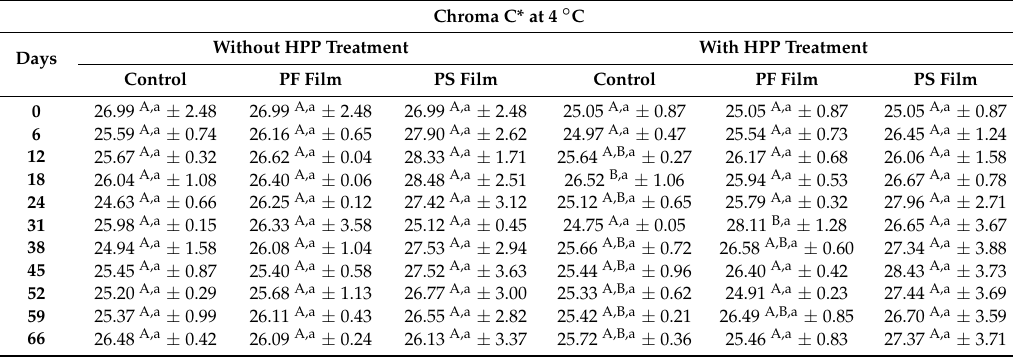
Table 4. Changes in C* values for ham slices treated or not with HPP, during storage at 4 ◦ C. Chroma C* at 4 ◦ C